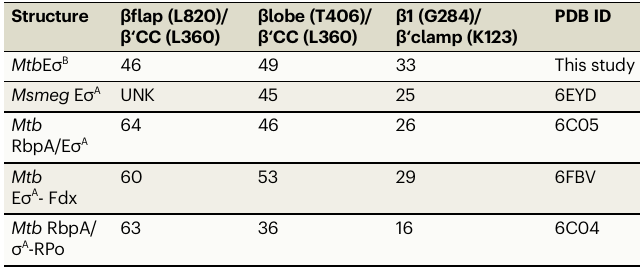
Table1| Conformational changesin RNAP(distancesbetween C α atoms in Å) Structure